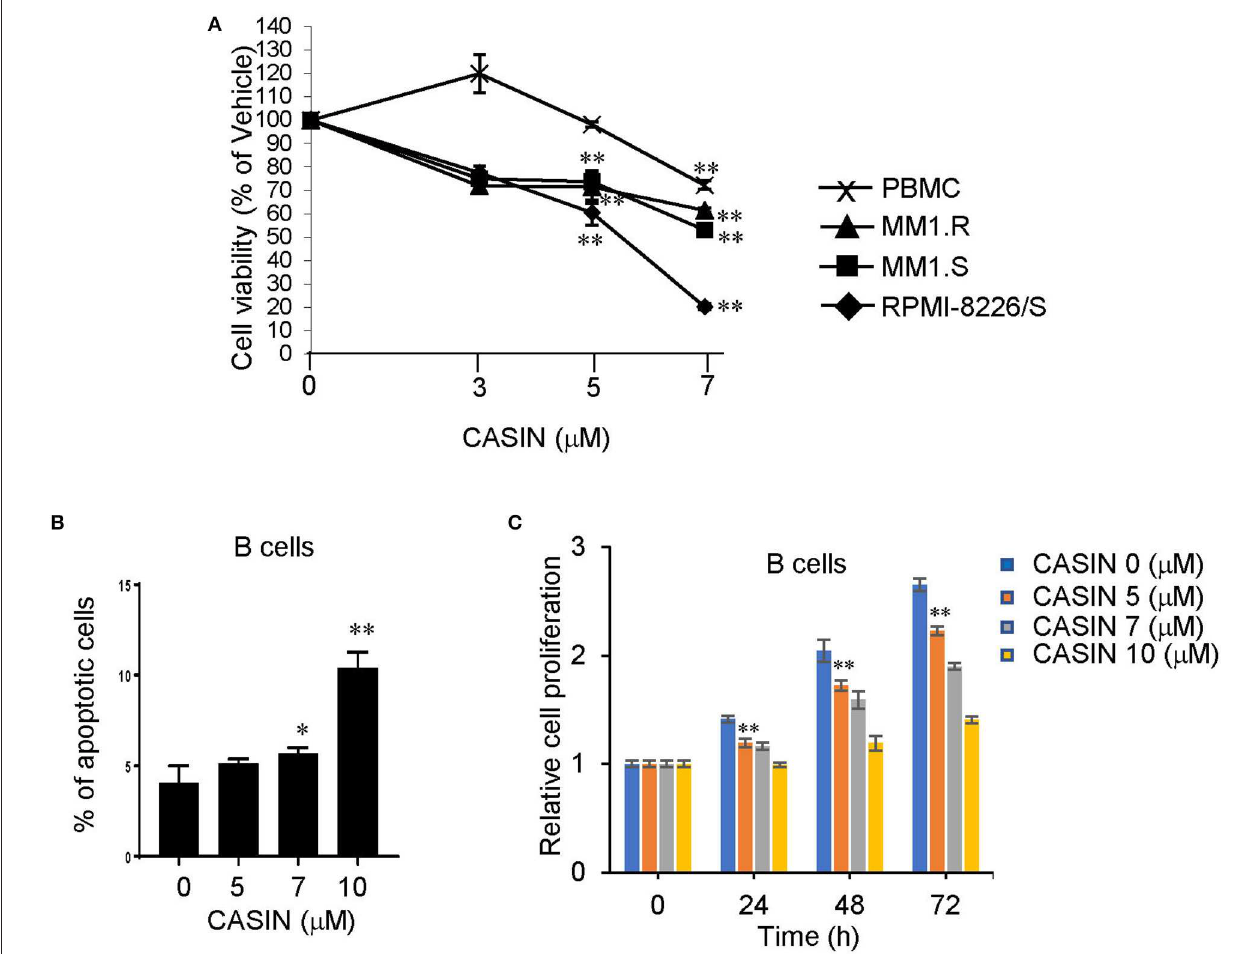
FIGURE 6 | CASIN has negligible side effects. (A) CASIN (5 µ M) inhibits viability of MM cell lines but not healthy human peripheral blood mononuclear cells (PBMC). RPMI-8226/S, MM1.S, and MM1.R MM cells and PBMC were treated with or without the indicated concentrations of CASIN for 4 days. Viable cells were measured using 3-(4,5-dimethylthiazol-2-yl)-5-(3-carboxymethoxyphenyl)-2-(4-sulfophenyl)-2H-tetrazolium (MTS) assay. Data were normalized to Vehicle group (0 µ M CASIN), ** P < 0.01 vs. Vehicle group. (B) CASIN (5 µ M) does not cause apoptosis of human B cells. Human B cells were treated with or without the indicated concentrations of CASIN for 2 days. Cell apoptosis was determined using flow cytometry analysis of Annexin V + cells; * P < 0.05 and ** P < 0.01 vs. Vehicle group. (C) CASIN (5 µ M) has modest inhibitory effect on proliferation of human B cells. Human B cells were treated with or without the indicated concentrations of CASIN for the indicated time. Cell proliferation was then measured. ** P < 0.01 vs. Vehicle group at same time point. Error bars represent means ± SD of triplicates and data are representative of three independent